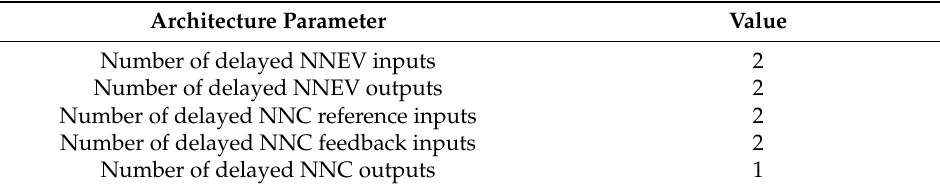
Table 2. MRC architecture characteristics.